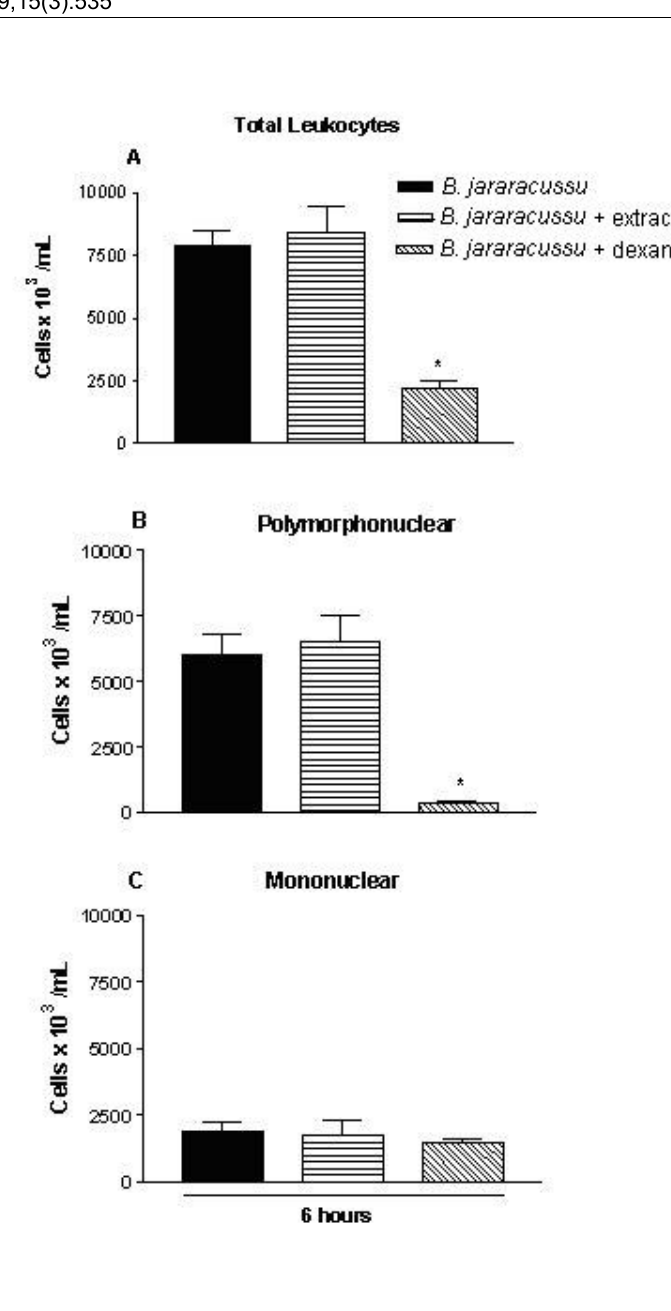
Figure 3. The effect of B. portulacoides ethanolic extract on leukocyte influx into the peritoneal cavity induced by B. jararacussu venom. Mice injected with B. jararacussu venom (0.4 mg/kg, i.p) dissolved in 1 mL of sterile saline and were pretreated with the extract (500 mg/kg, i.p.). Another group was pretreated with dexamethasone (1 mg/kg i.p.). Total leukocytes ( A ), PMN cells ( B ) and MN cells ( C ). Mice were killed after six hours and inflammatory exudates were withdrawn after washing the peritoneal cavity. Results are presented as mean ± SEM ( n = 5). * p <